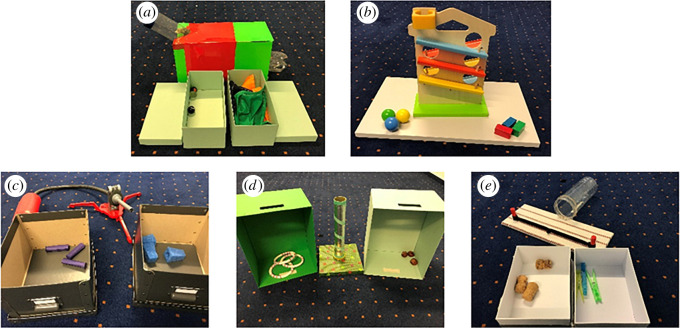
Objects and apparatuses used in the familiarization trials (a,b) and test trials (c–e) of the pragmatically modified Sefo task in study 2b.